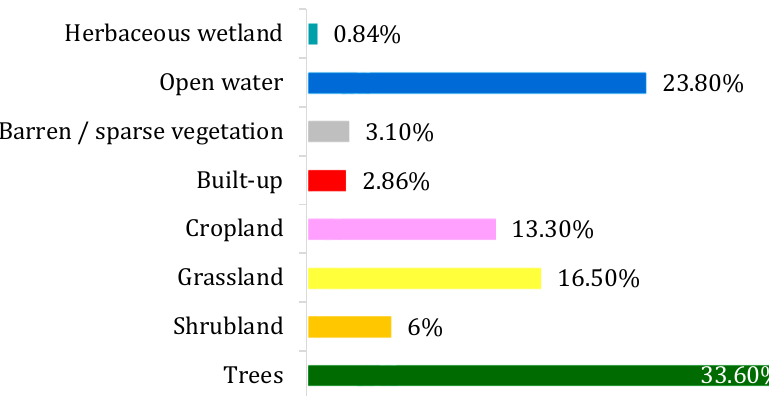
Figure 4. Bar chart showing the distribution of the eight classes in the dataset.